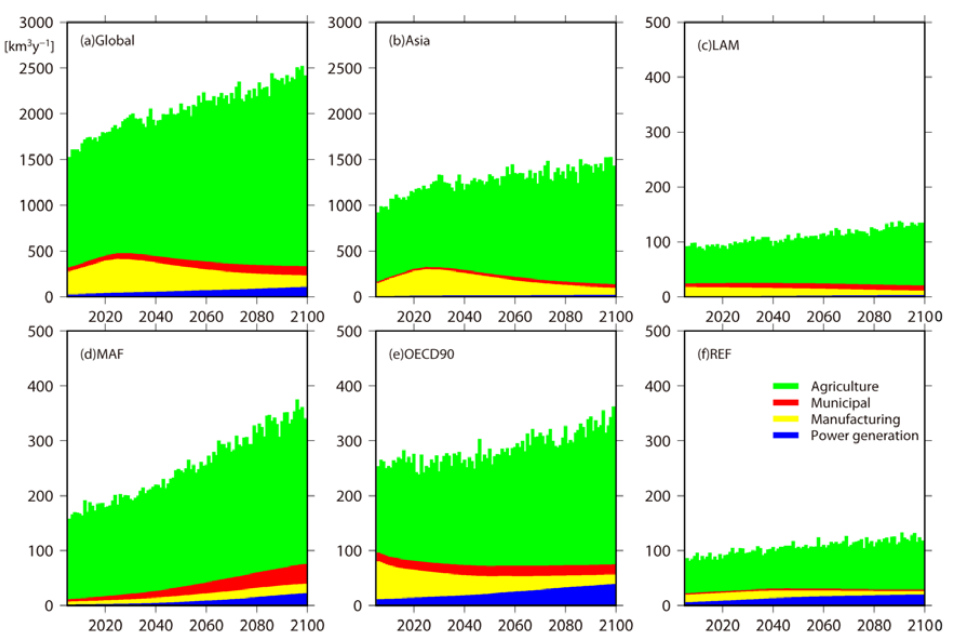
Figure 2. Consumptive water requirements for ( a ) global total, ( b ) Asia, ( c ) Latin America (LAM), ( d ) Middle East and Africa (MAF), ( e ) OECD member countries as of 1990 (OECD90), and ( f ) countries with transitional economies (REF) under the BAU